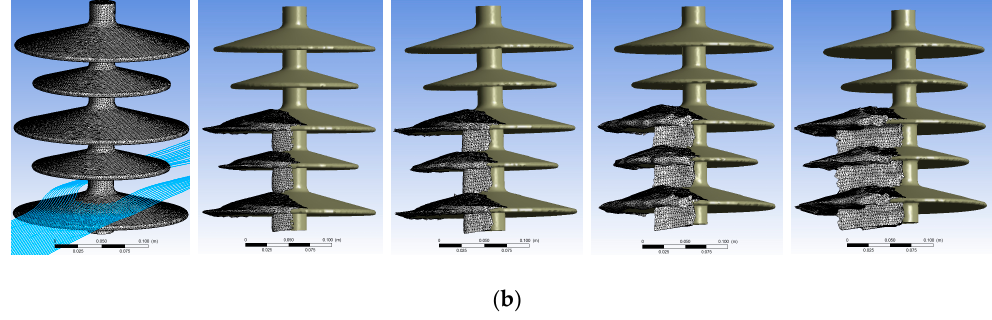
Figure 11. Icing shapes during a four-hour test and simulation. Icing was removed from the top layer for comparison. ( a ) The changing ice shapes on insulator sample (from left to right: t = 60, 120, 180, and 240 min); ( b ) Simulated ice shapes based on climate parameters and mesh reconstruction (from left to right: t = 0, 60, 120, 180, and 240 min).